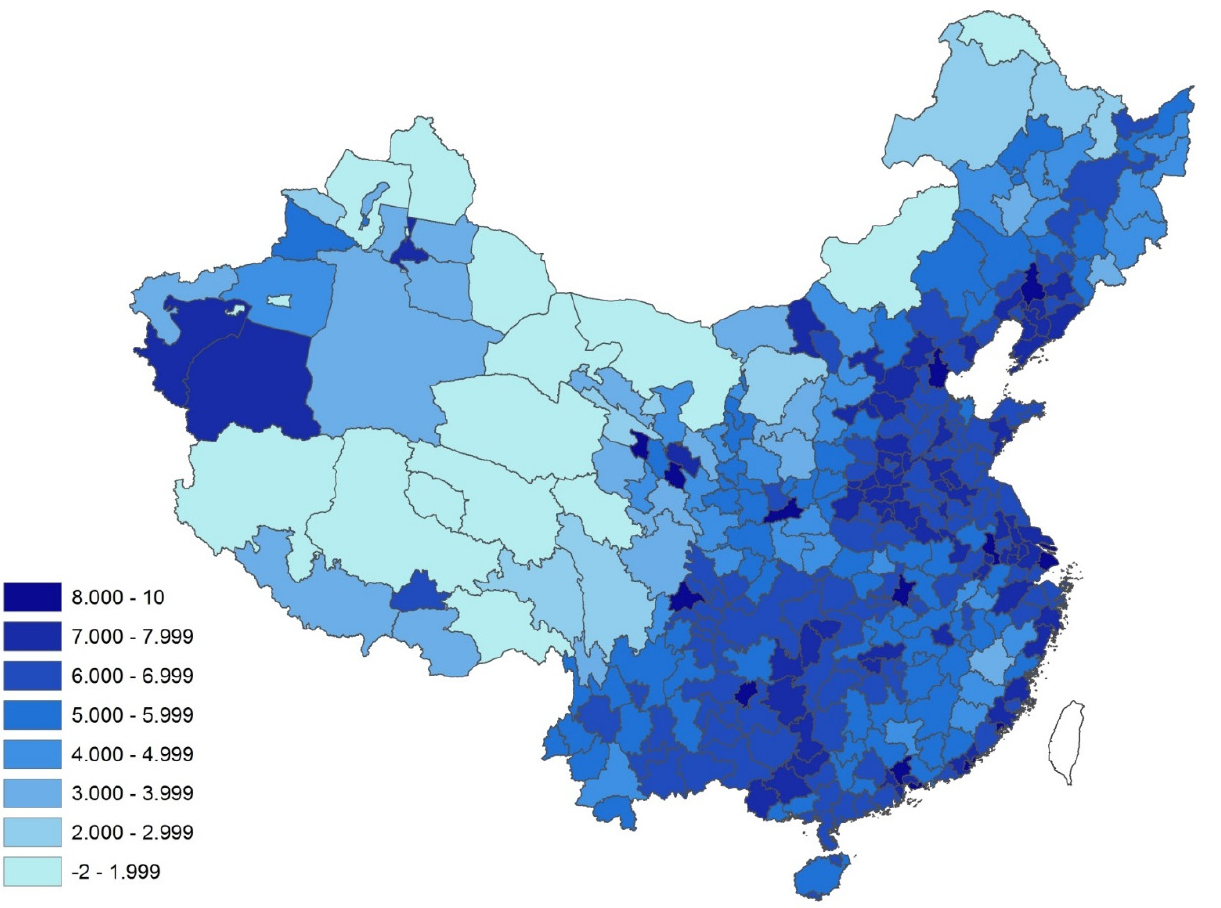
Figure 2. Map of predicted prefectural CES-D scores for the urban population ( n =